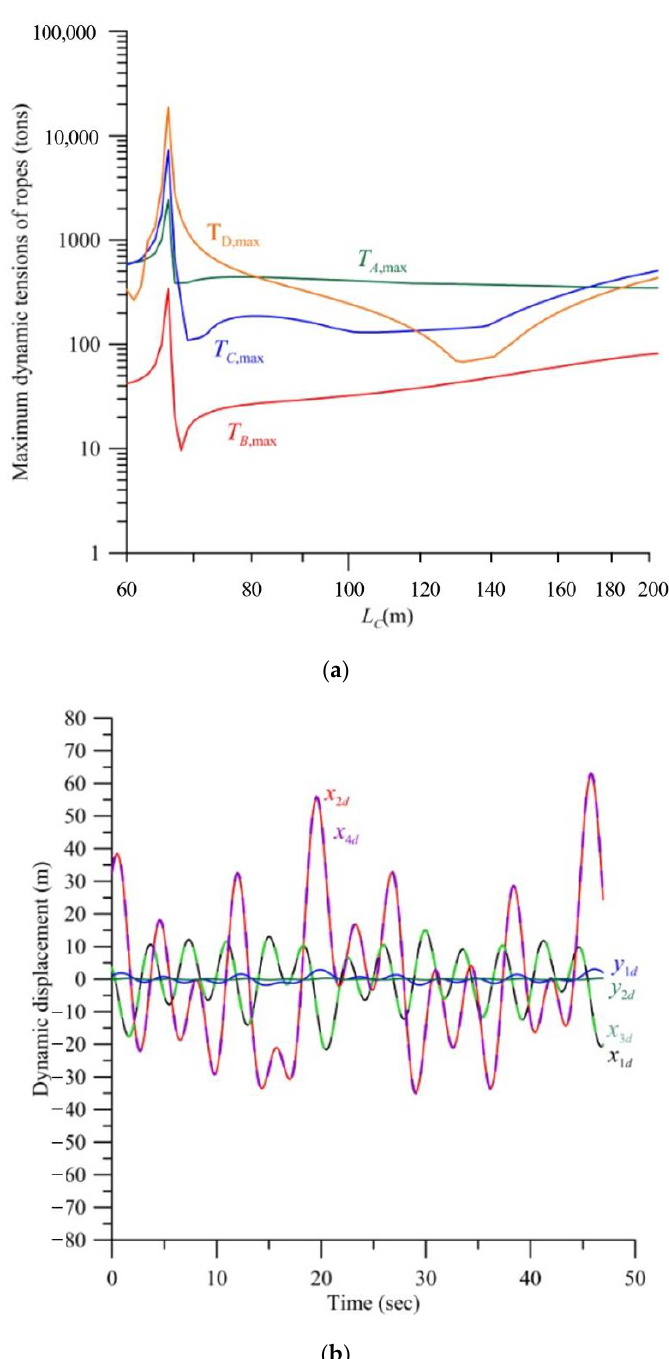
Figure 5. Dynamic tensions of ropes and Dynamic displacements of elements under the typhoon irregular wave. ( a ) Dynamic tension of the four ropes under the typhoon irregular wave as a function of the diving length for L E = 100 m; ( b ) Dynamic displacements of the four elements at resonance for L C = 66